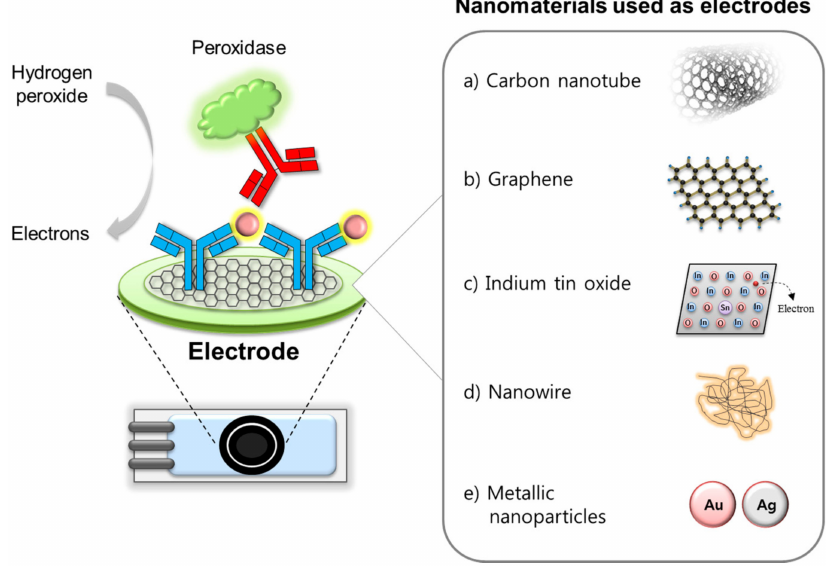
Figure 2. Nanomaterials used as electrodes or supporting solid matrices to enhance the analytical performance of electrochemical